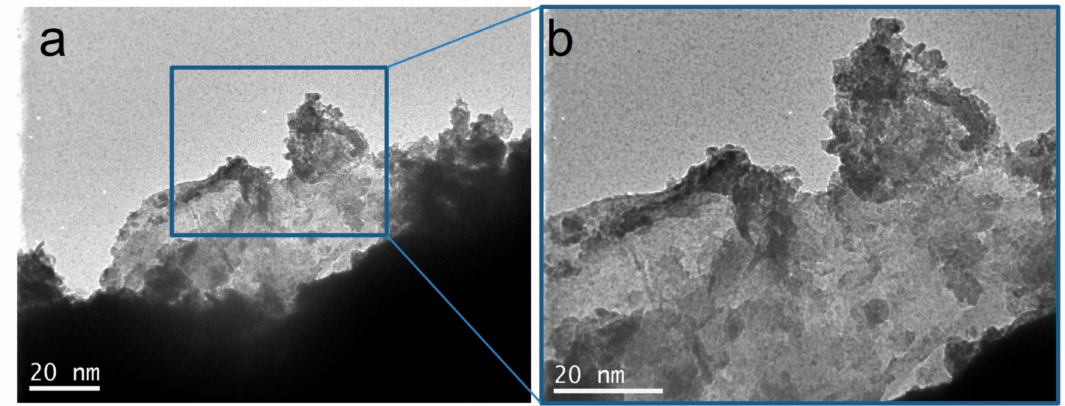
Figure 8. TEM images of pure TiO 2 : ( a ) image captured from random area; ( b ) magnified images of the area selected at ( a